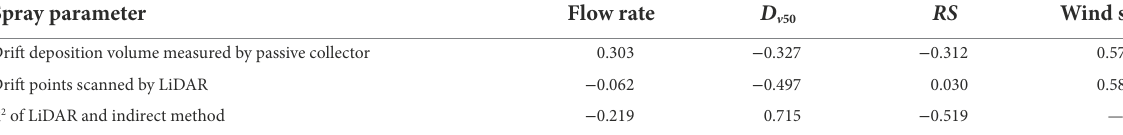
TABLE 3 Coefficients of spray parameters, according to the linear analysis of drift points, deposition volume, and R 2 . Spray parameter